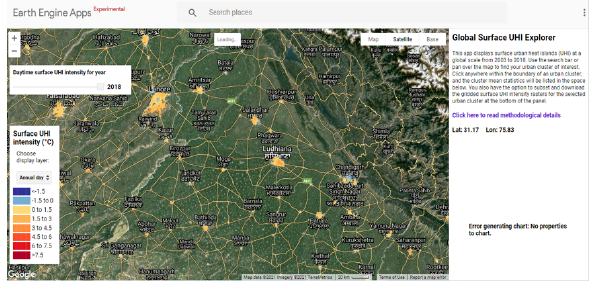
Figure 6: Results (MODIS Terra- Aqua Dataset for LST Estimation